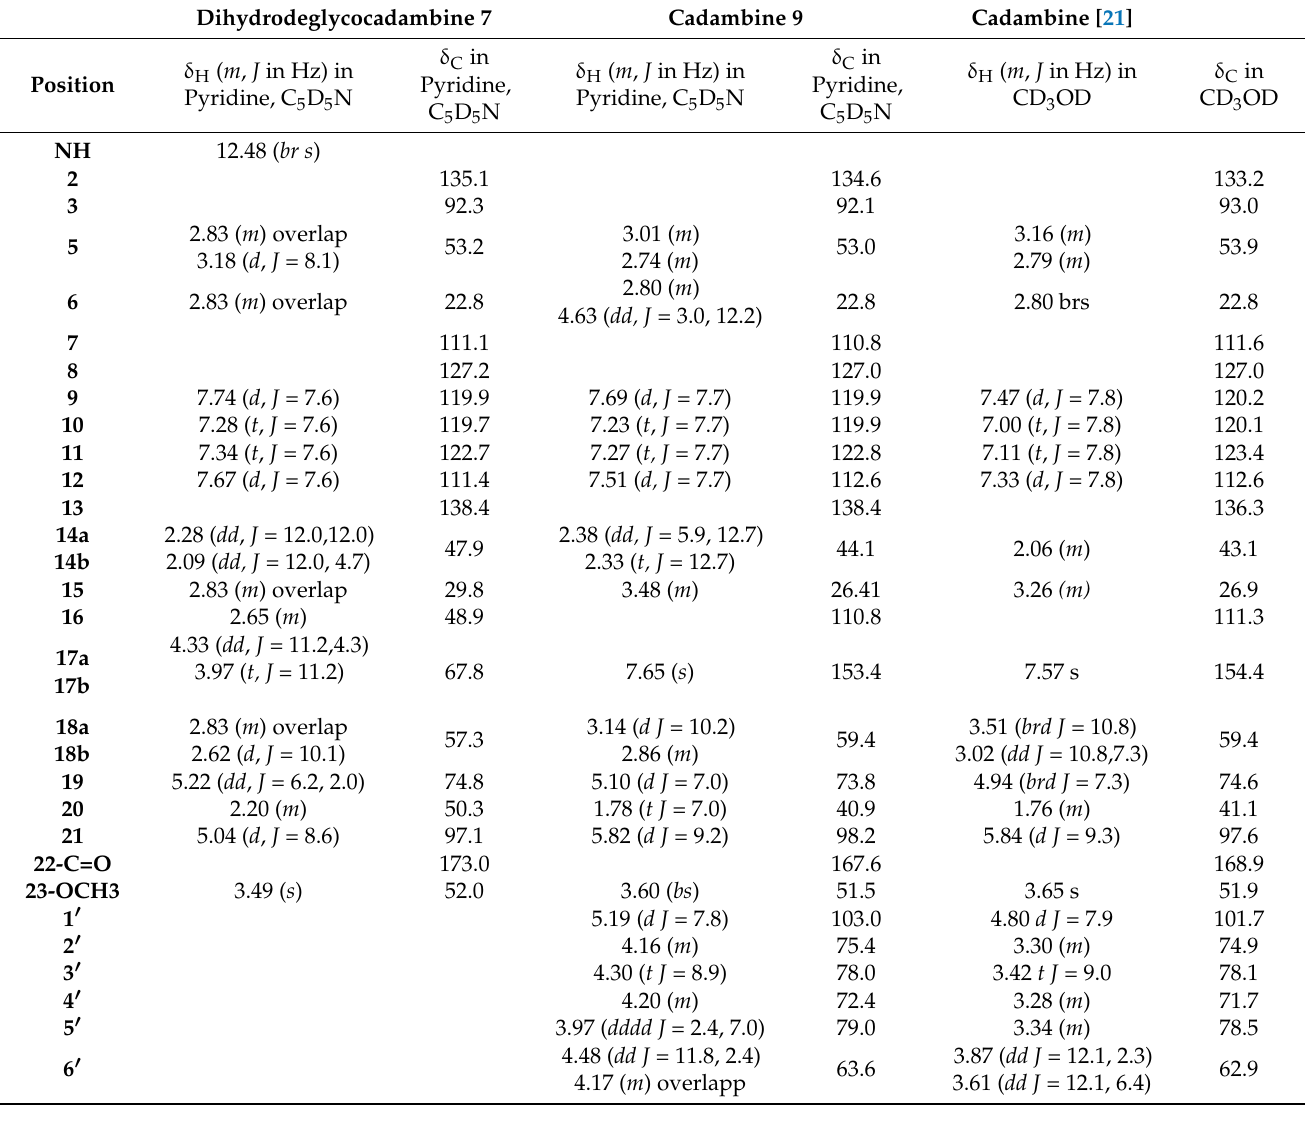
Table 2. 1 H-NMR (600 MHz) and 13 C-NMR (150 MHz) spectral data of dihydrodeglycocadambine 7 in C 5 D 5 N.